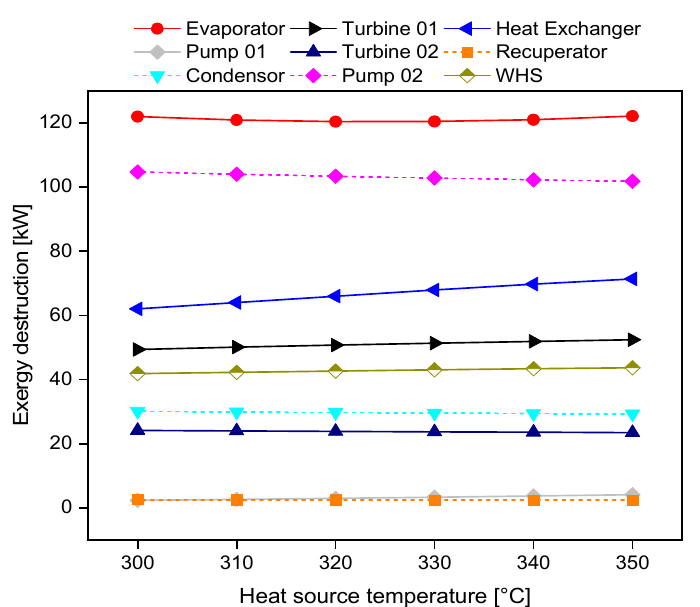
Figure 9. Exergy destruction of different components with different heat source temperatures in August.